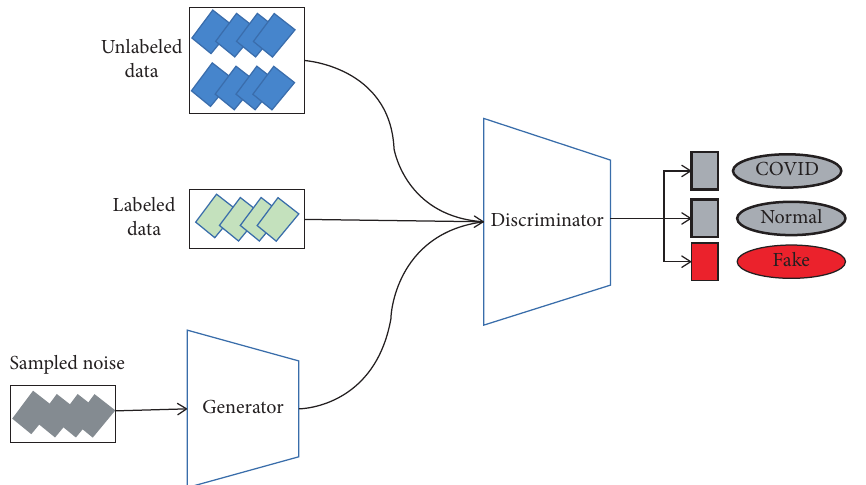
Figure 4: Architecture of the proposed semisupervised classifier with classes K +1